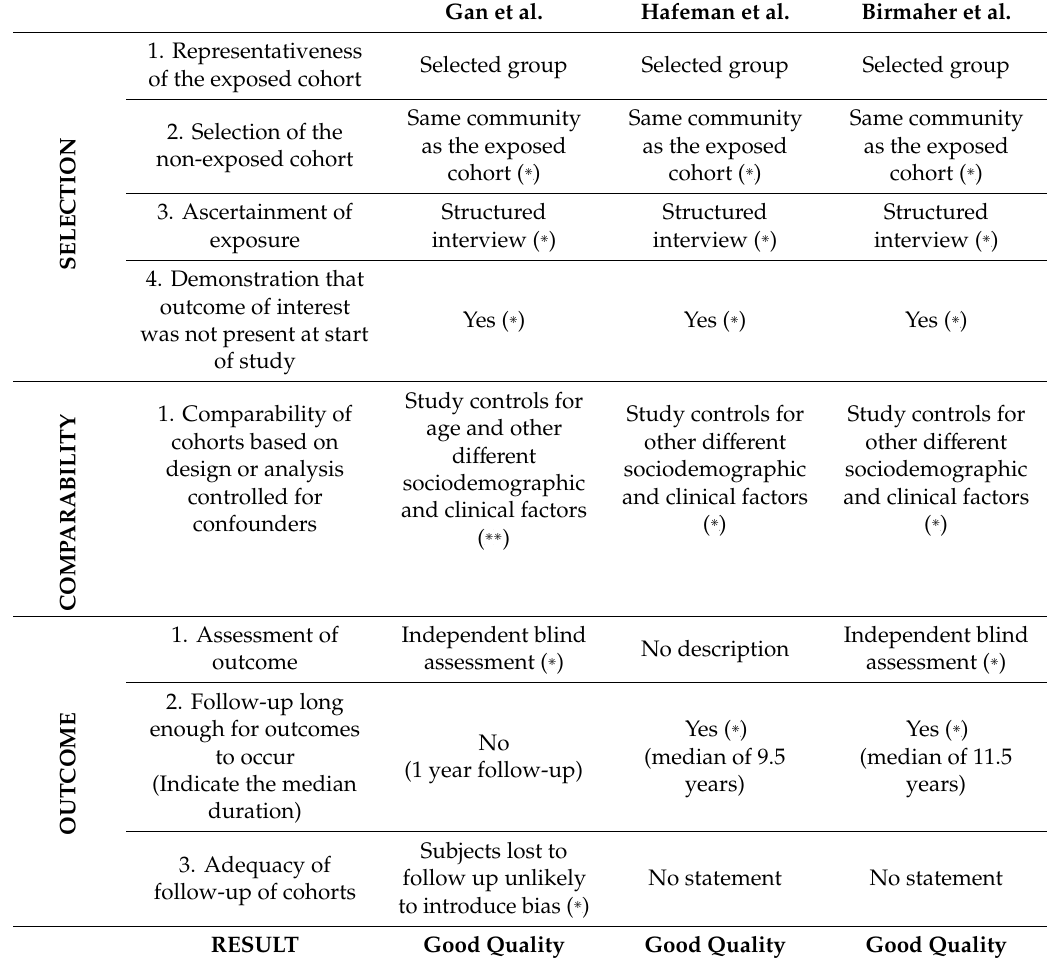
Table 2. Quality Assessment based on Newcastle-Ottawa Quality Assessment Form for Cohort Studies.